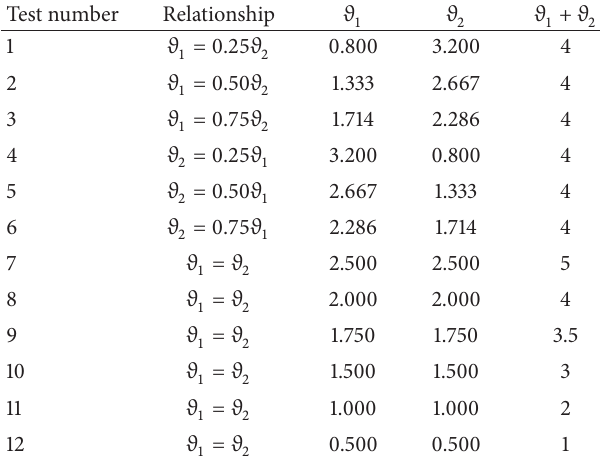
Table 3: Combinations of velocity equation coefficients in different tests.